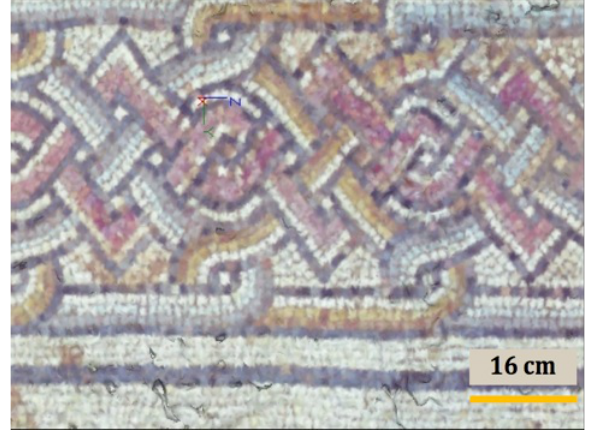
Figure 4: extract of 3D model of mosaic #3. Squared tessera can be remarked.